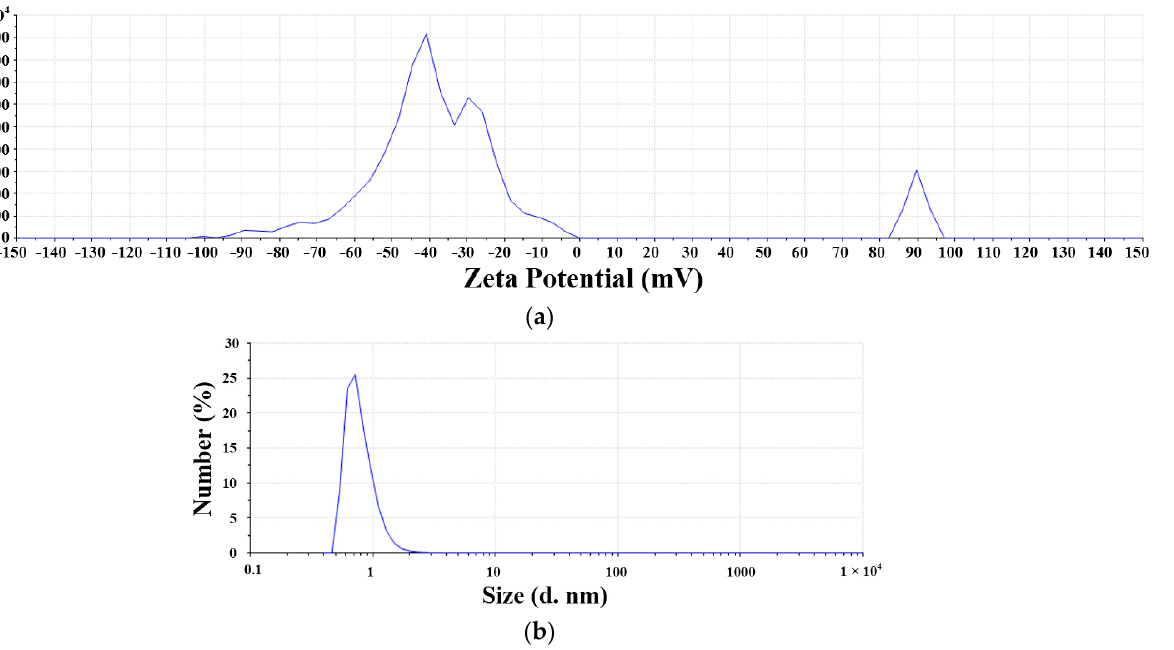
Figure 10. Characteristics of nanosilver colloid with a smaller size: ( a ) zeta potential distribution; ( b ) number PSD.